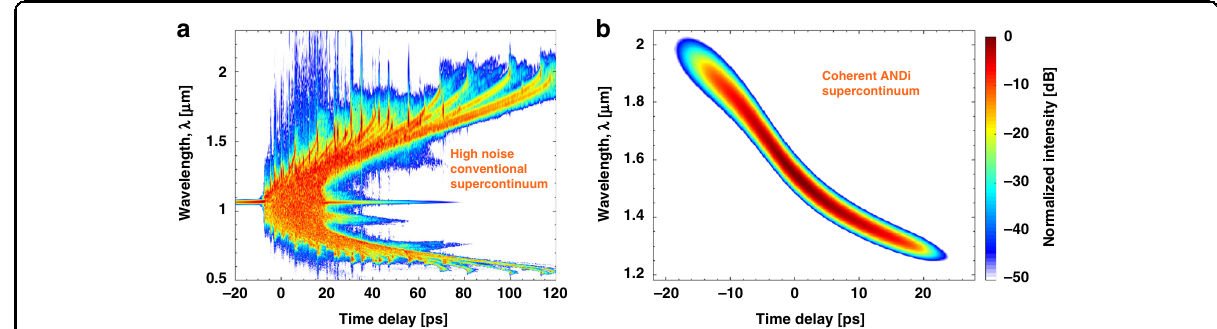
Fig. 1 Output of SC sources. Simulated single-shot output spectrograms of ( a ) a typical conventional long-pulse pumped SC source and ( b ) a typical fully coherent ANDi SC